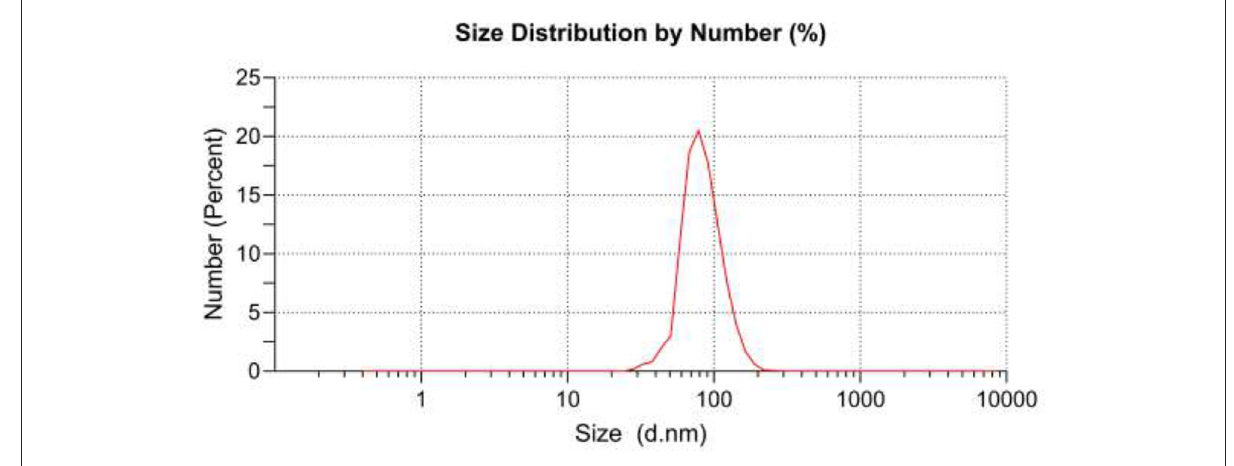
FIGURE2 Size distribution of TiO 2 nanoparticles obtained by DLS.